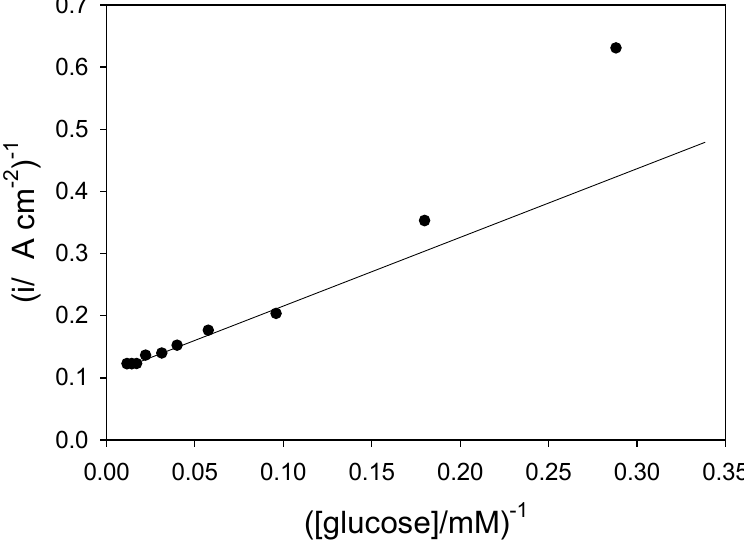
Figure 8. Plot of inverse current versus inverse substrate concentration for a biosensor consisting of glucose oxidase immobilized within an MPA (3-mercaptopropionic acid) self assembled monolayer using benzoquinone as a soluble mediator. The graph is constructed from batch amperometry data published by Goodring et al [3c]. Enzyme loading = 0.7 pmol cm -2 , [benzoquinone] = 1